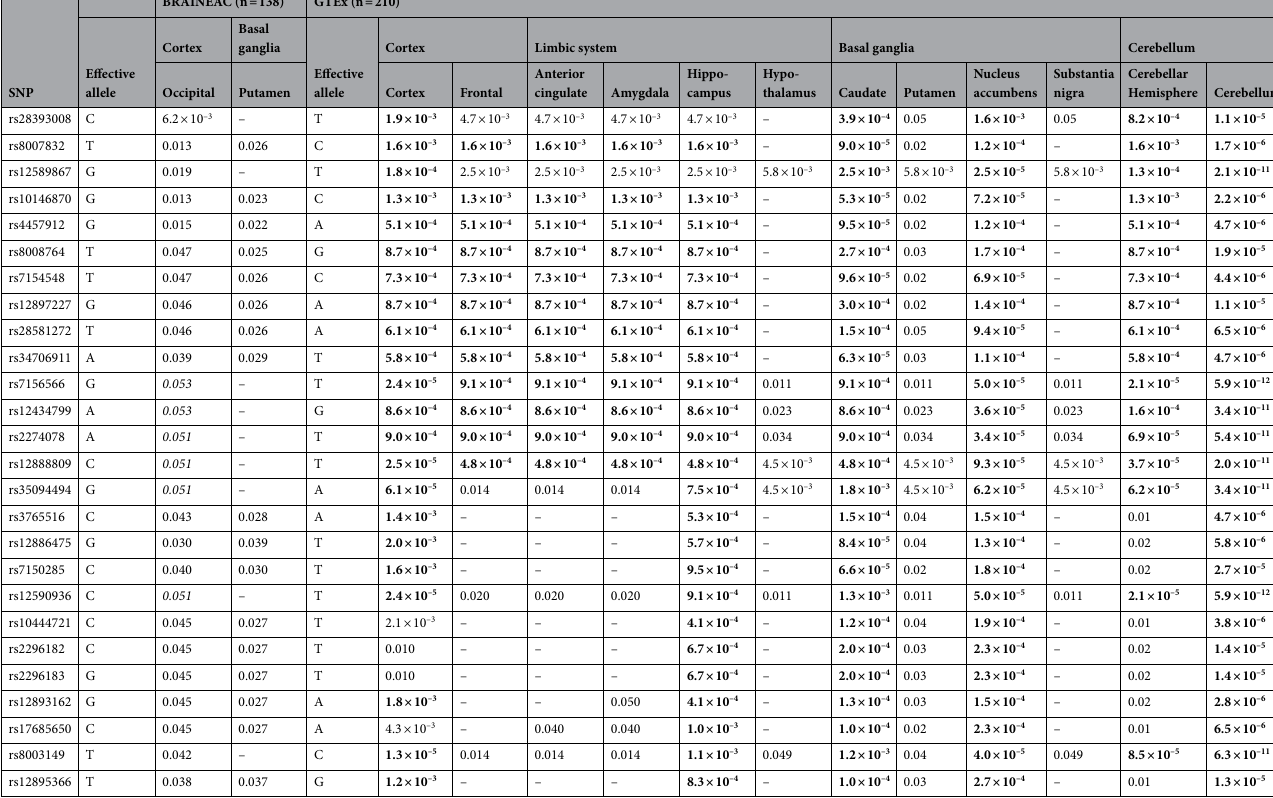
Table 2. p values for associations between schizophrenia-risk SNPs and KTN1 mRNA expression in brain. “– “, p > 0.05. The bold p values correspond to q < 0.05. Some p values larger than but close to 0.05 are listed